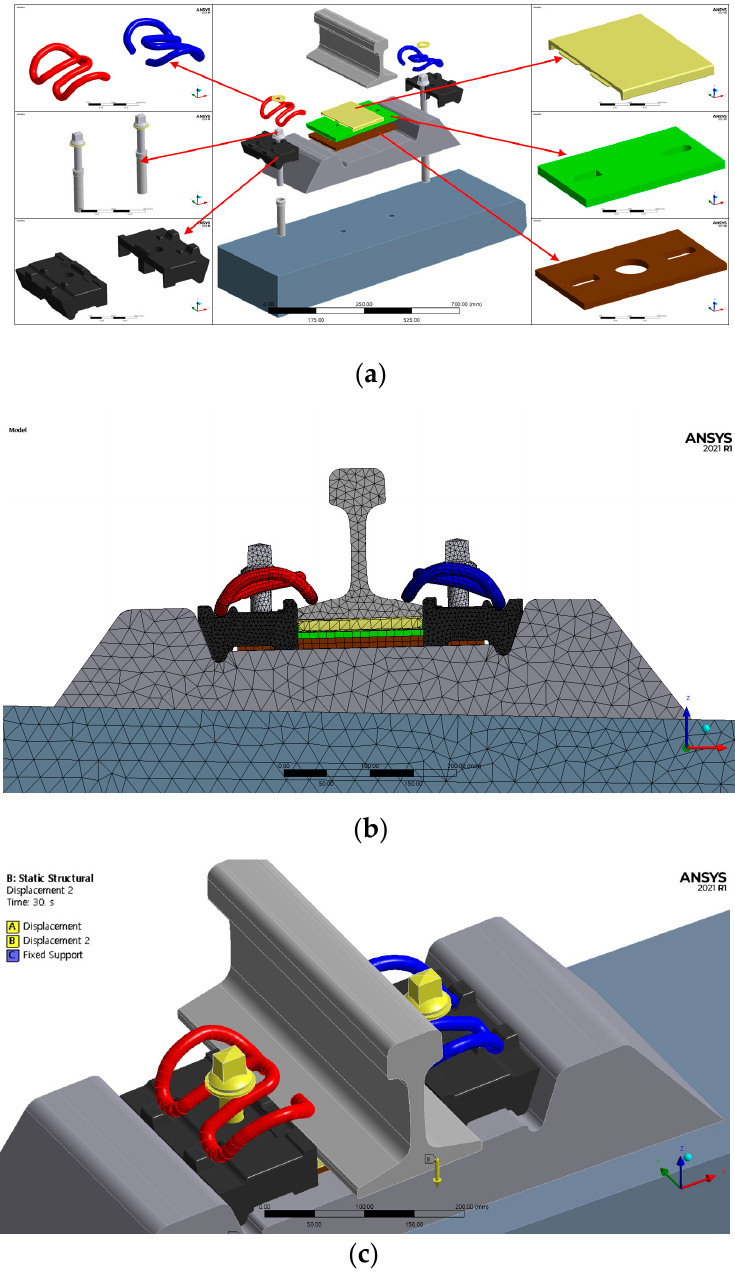
Figure 9. Three-dimensional modeling and boundary conditions. ( a ) Detail of FEA modeling; ( b ) detailed front (mesh); ( c ) screw spike displacement. Table 2. Material properties of the finite element model.